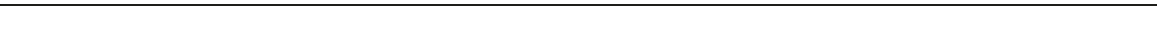
Fig. 4 Examples of IBD-upregulated enhancers and linked TSS and genes. Each larger panel shows: genome browser with the average CAGE expression in TPM on both strands, UCSC gene models, TSS-enhancer-linkage through expression correlations (Pearson correlation coef fi cients are indicated by color, only positive correlations are shown) and CAGE-de fi ned enhancers (black). Green indicates data on forward strand, purple on the reverse strand. Left part of lower panel shows a zoom-in of the enhancer region, with CAGE signal intensity as above, ENCODE DHS peaks and TF ChIP-seq peaks 26,66 . ChIP-seq peaks are labeled with cognate TF name. Primer locations for qPCR analysis are indicated as double arrows. Right lower panel shows corresponding qPCR analysis of eRNA expression in CDa, UCa and Ctrl samples on both strands as boxplots, relative to the PIAS4 reference gene. a An enhancer upstream of the NOD2 TSS. An enhancer region was detected upstream of the TSS of NOD2 , a key gene in IBD pathogenesis with strong support from ENCODE cell line data. b An enhancer in the CXCL1-3 , 5 , 6 , 8 cytokine cluster. Several enhancer regions within a cluster of chemokine genes ( CXCL1-3 , CXCL5-6 , and CXCL8 , all upregulated in IBD) were detected. The analysis is focused on a single enhancer linked to the above gene TSSs (for ease of visualization, only links between this enhancer and TSSs are shown). c An enhancer between CXCR1 and CXCR2 . An enhancer between CXCR1 and CXCR2 (receptors for the cytokines in panel b ) was detected. This enhancer overlapped multiple ENCODE TF ChIP-seq peaks, and the UC-associated rs11676348 SNP. Note the two alternative TSSs for CXCR2 . In the lower panel, a track with disease-associated SNPs is